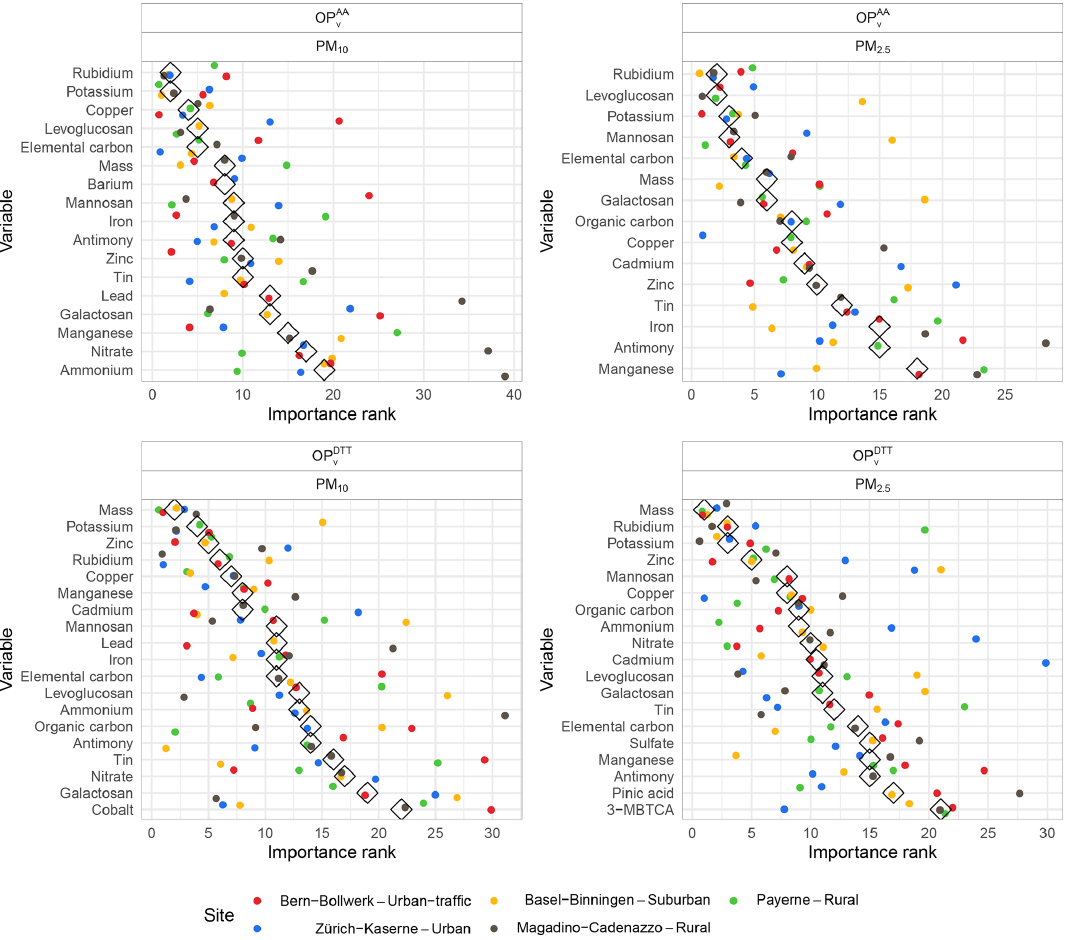
Figure 5. Random forest importance plots of the top independent variables for two OP v assays, two particulate size fractions, and five sampling sites. The large open diamonds represent the variables’ medians, and the variables are ordered by median